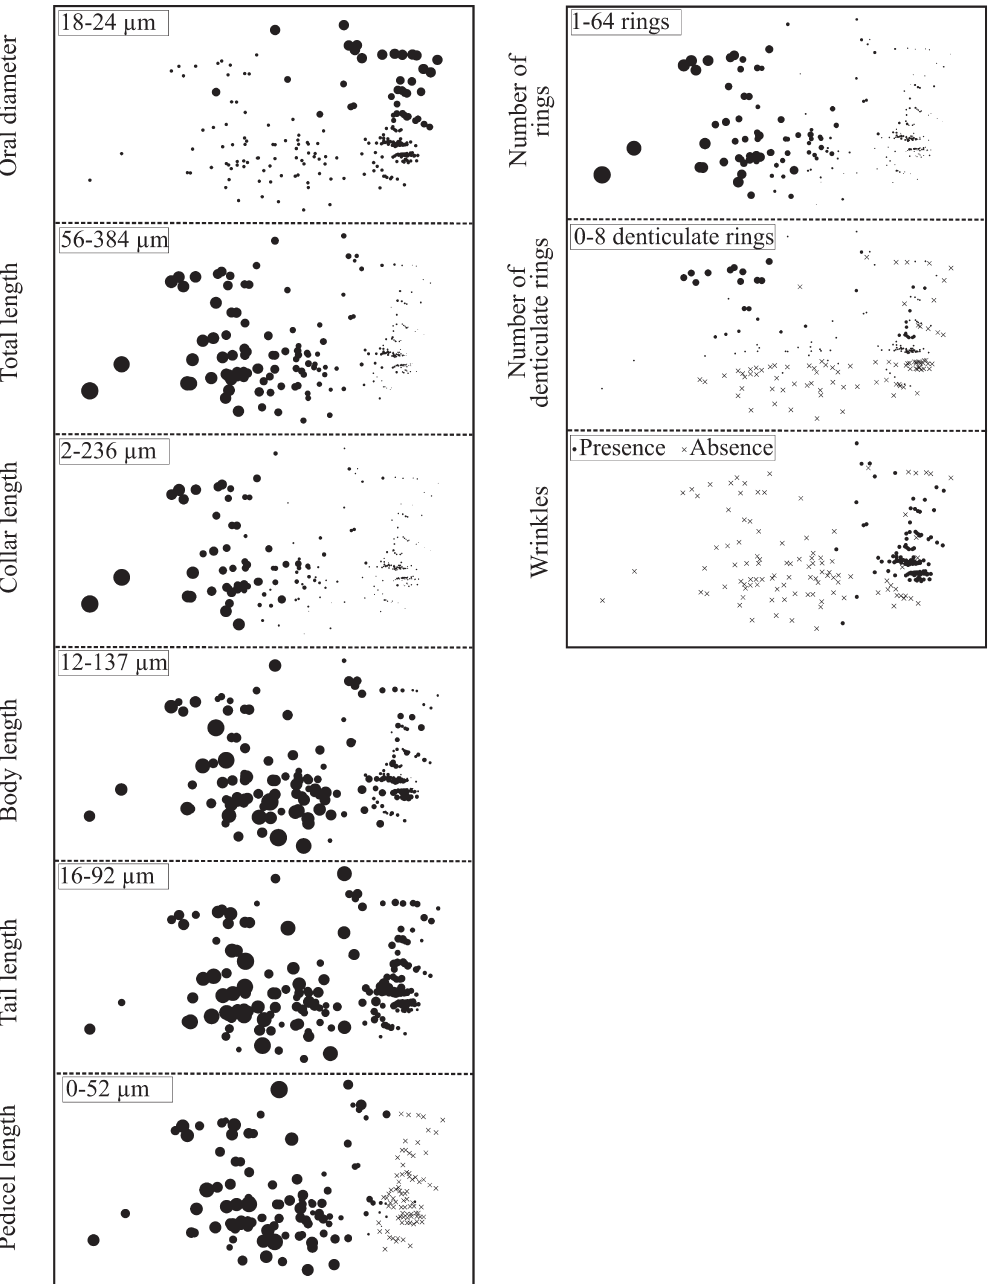
Fig . 4. – Multi-dimensional Scaling ordination of Helicostomella loricae based on the nine morphological parameters examined, with bubble plots superimposed for each variable. each bubble represents a single specimen, and its size is proportional to the value measured. crosses indicate absence of the